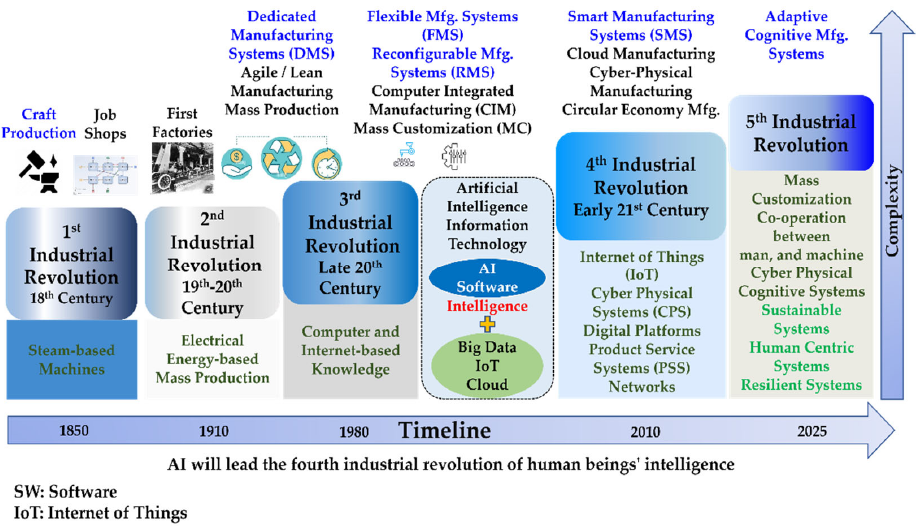
Figure 1. Industrial Revolutions with key milestones and significance of AI towards human beings’ intelligence (derived from [7,8]). intelligence (derived from